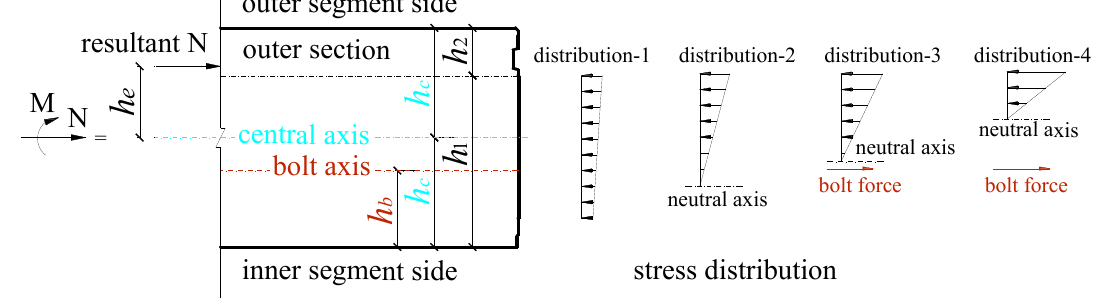
Figure 22. Stress distributions at the joint core section in a positive case.